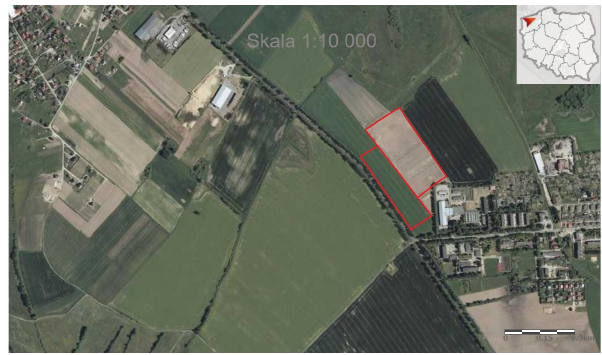
Figure 1 – Orthoimage of test area